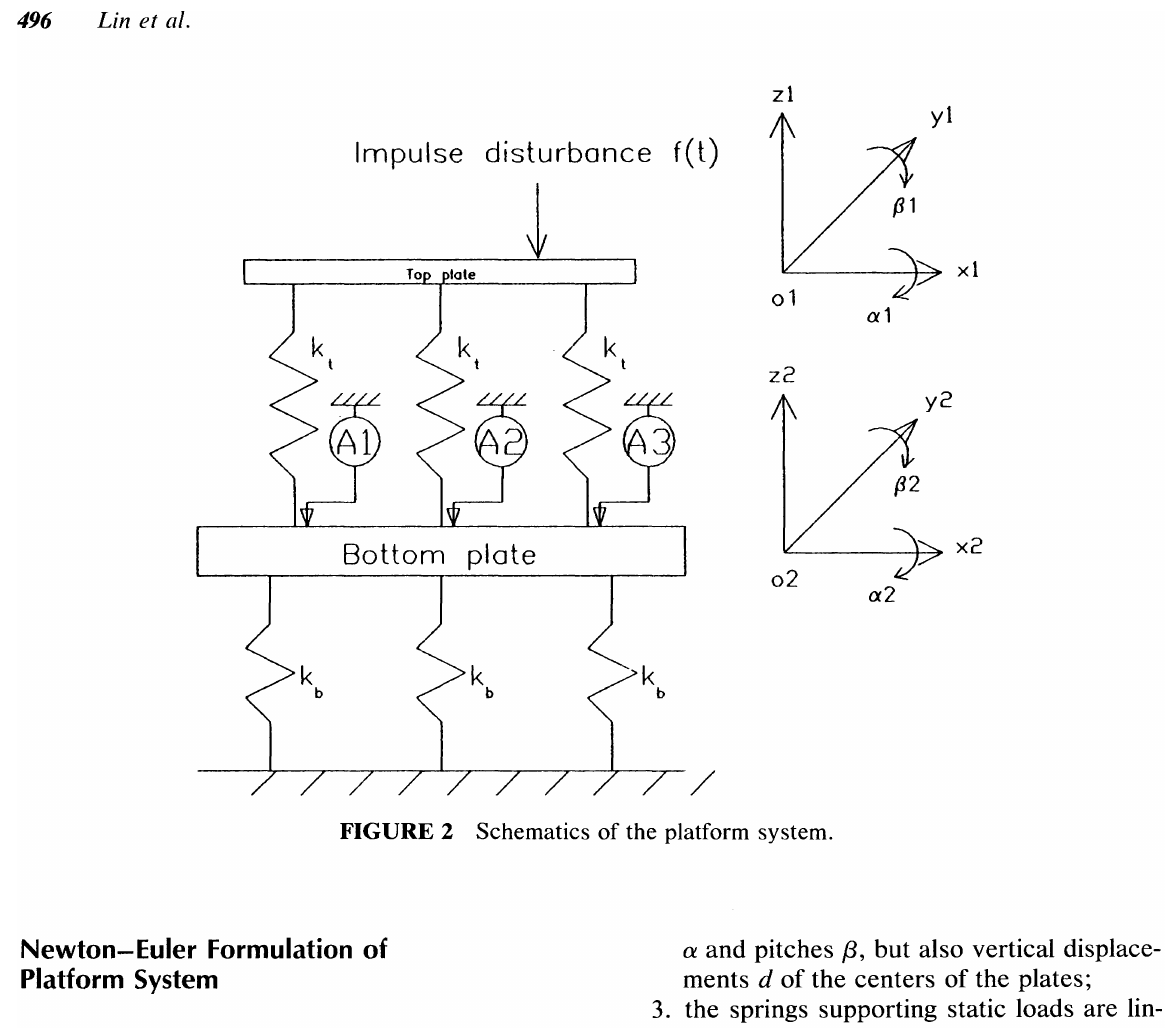
FIGURE 2 Schematics of the platform